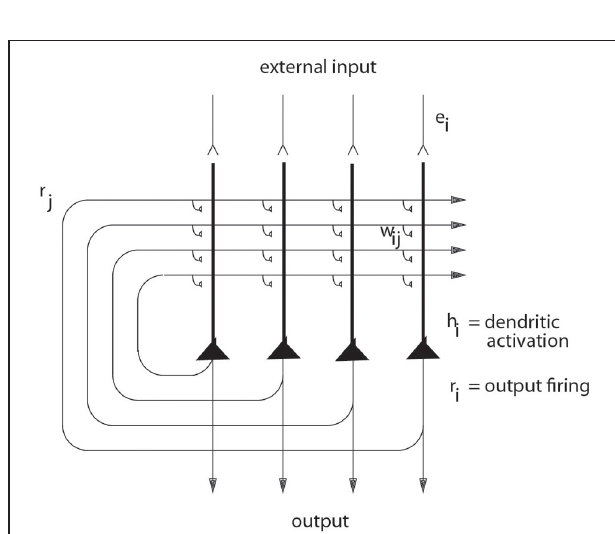
FIGURE 2 | The numbers of connections from three different sources onto each CA3 cell from three different sources in the rat (After Treves and Rolls, 1992; Rolls and Treves, 1998).